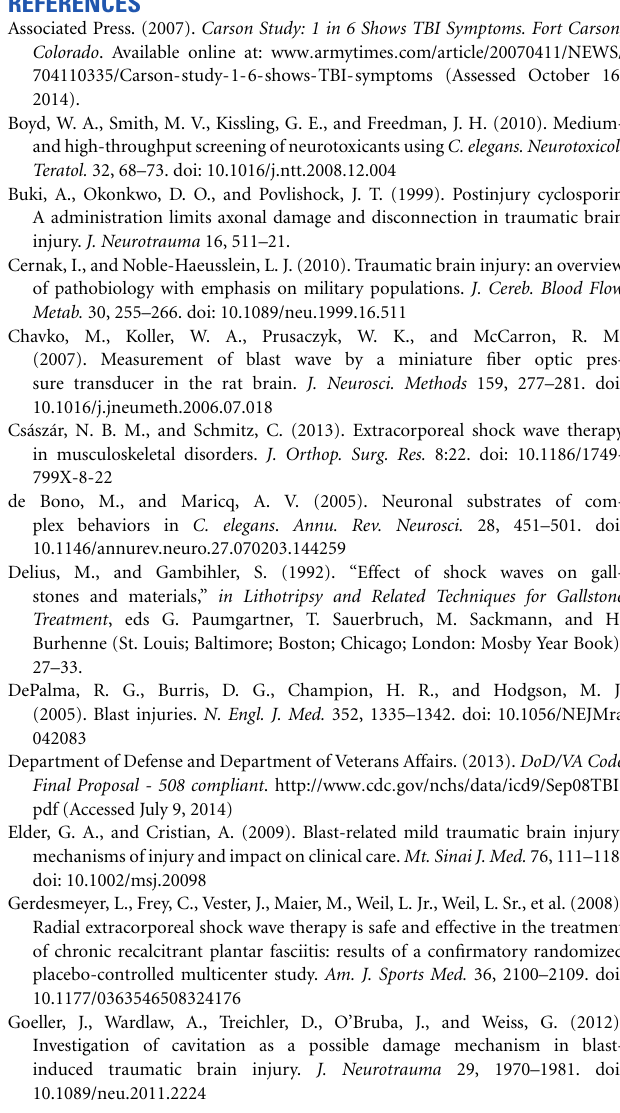
Table S1 | Tracking Settings used in WormLab